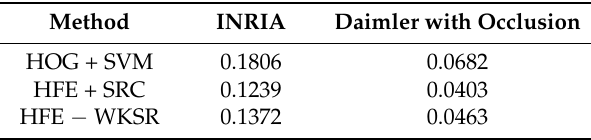
Table 1. Average running time